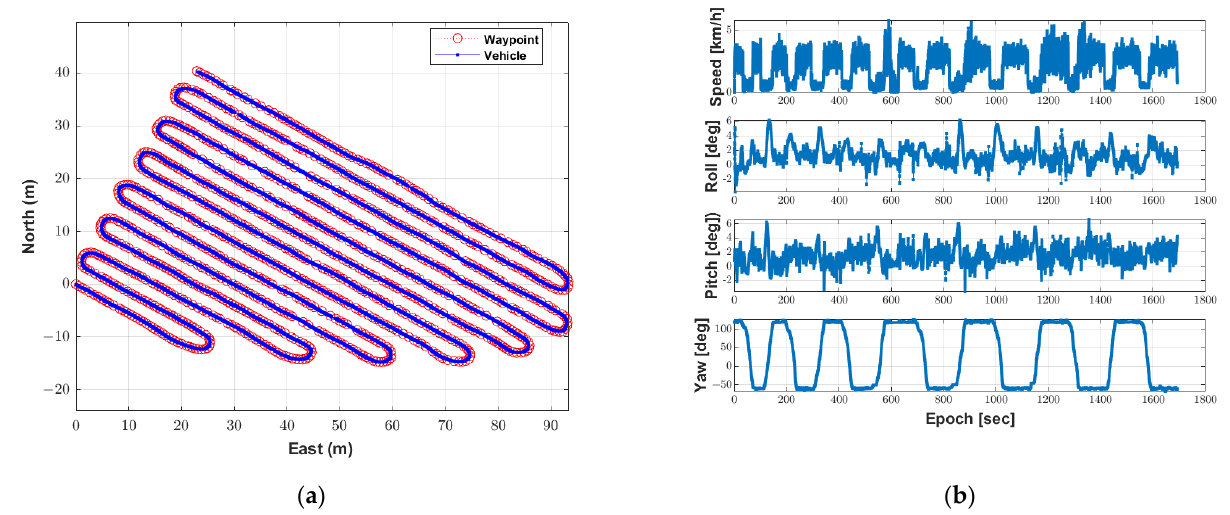
Figure 12. Location, speed and attitude of the speed sprayer during the second test of the autonomous driving-based spraying. ( a ) Location of the speed sprayer with waypoints. ( b ) Speed and velocity of the speed sprayer.